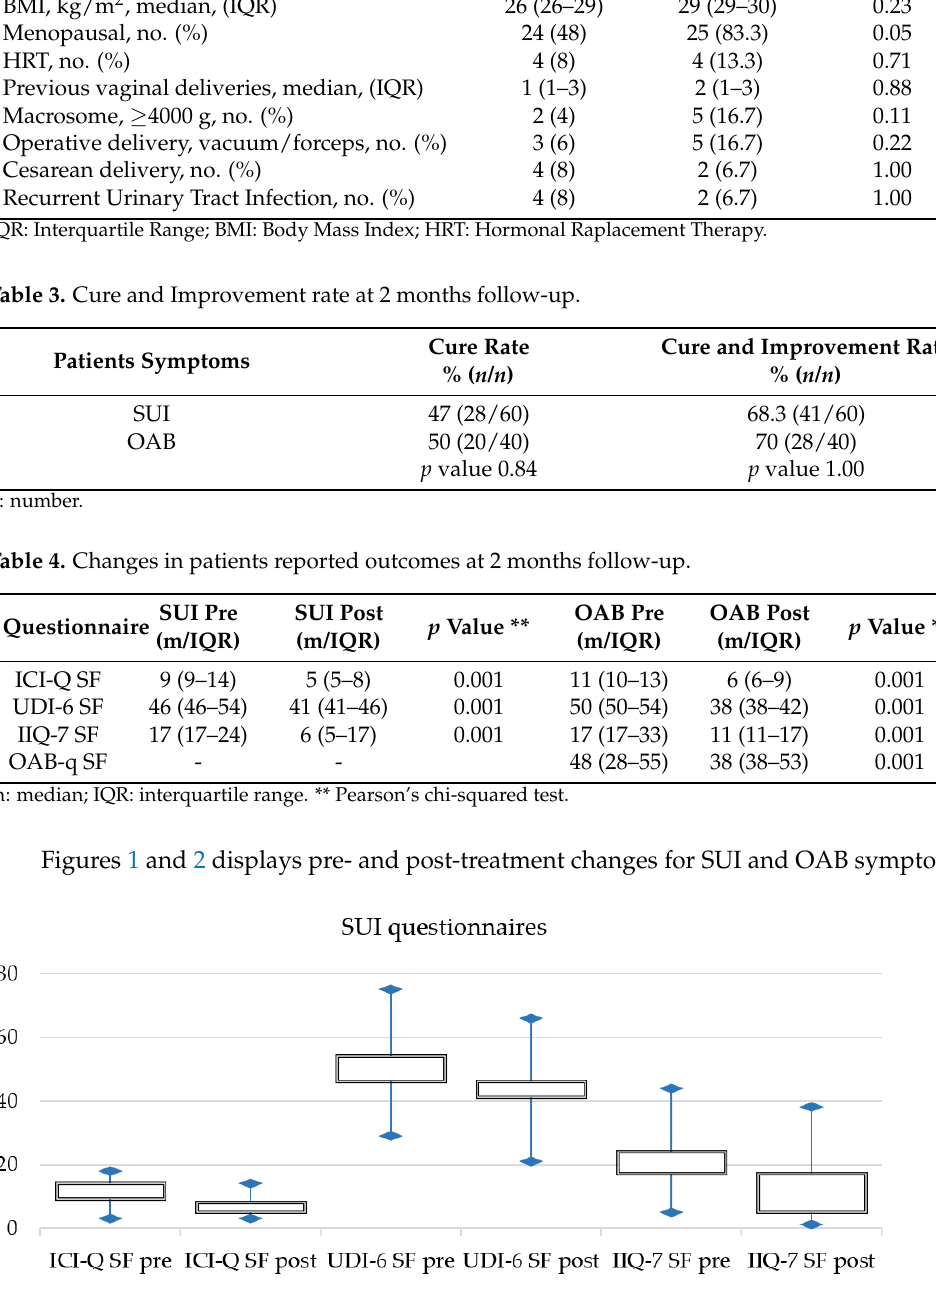
Table 3. Cure and Improvement rate at 2 months follow-up.